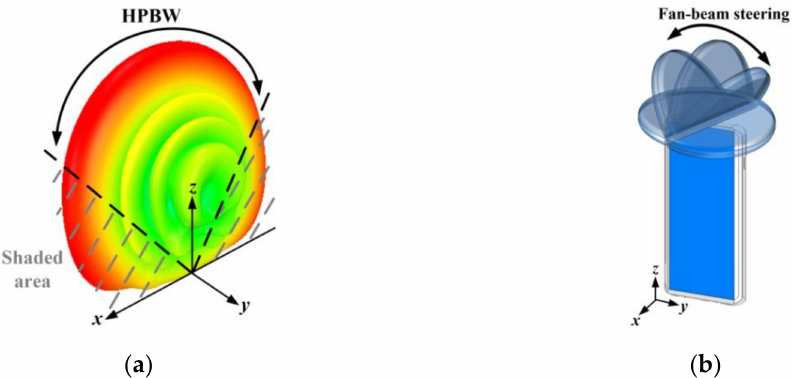
Figure 1. Fan-beam radiation pattern and hemispheric beam coverage: ( a ) fan-beam radiation pattern, and ( b ) hemispheric beam coverage required in 5G mobile